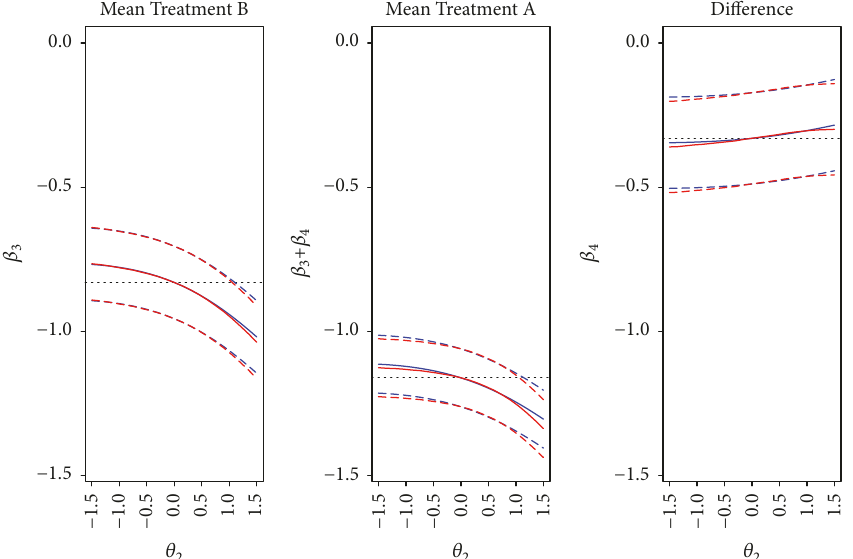
Figure 6: Clinical trial example: 95% CI for 𝛽 3 , 𝛽 3 + 𝛽 4 , and 𝛽 4 . The blue lines use the Copas and Eguchi method, the red lines use the least false method, and the horizontal line is at the MAR